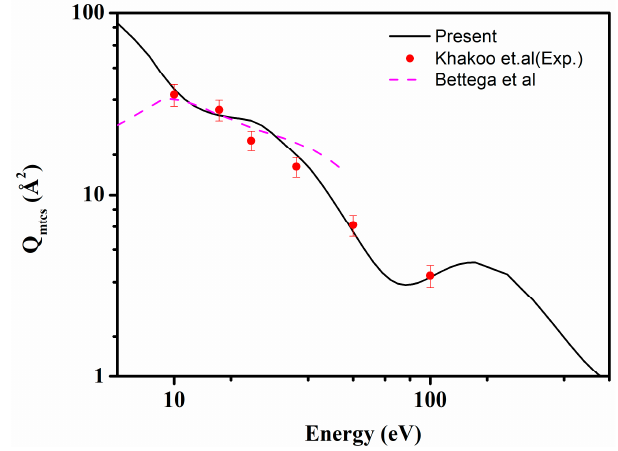
Figure 9. Momentum transfer cross-section of butan-1-ol: solid (black) line shows present results, circles (red) represent experimental results of Khakoo et al. and dashed (pink) line shows calculated results of Bettega et al.